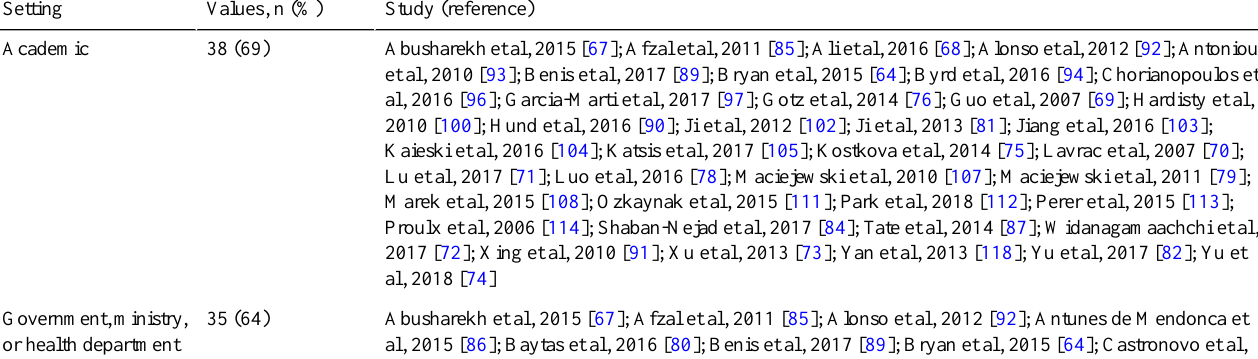
Table 3 details the target audience in the included papers.